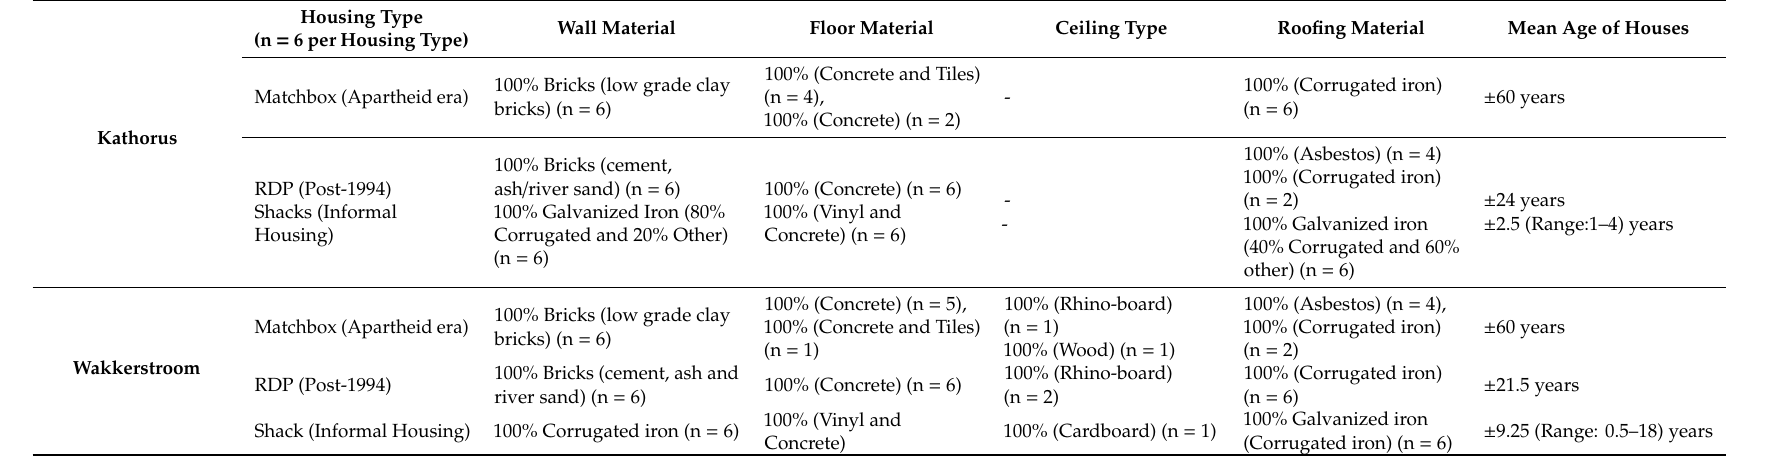
Table 2. Percentage of building material used to construct each housing type, as per expert opinion and self-reported accounts. The number of households which used a specific form of building material are